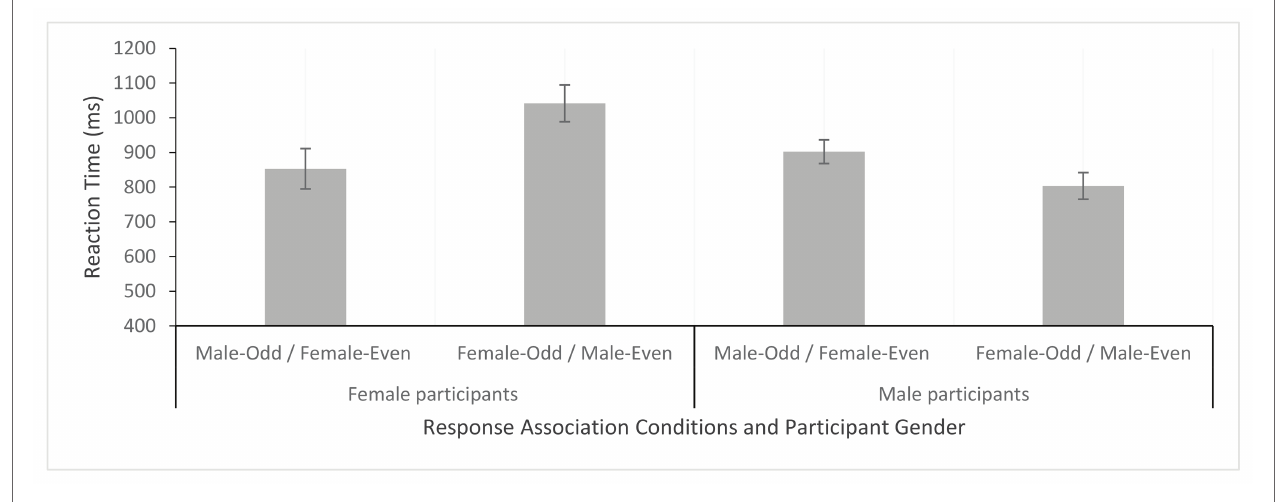
FIGURE 2 | Mean reaction times (with standard error bars) for each response association condition (male-odd/female-even, female-odd/male-even) and participant